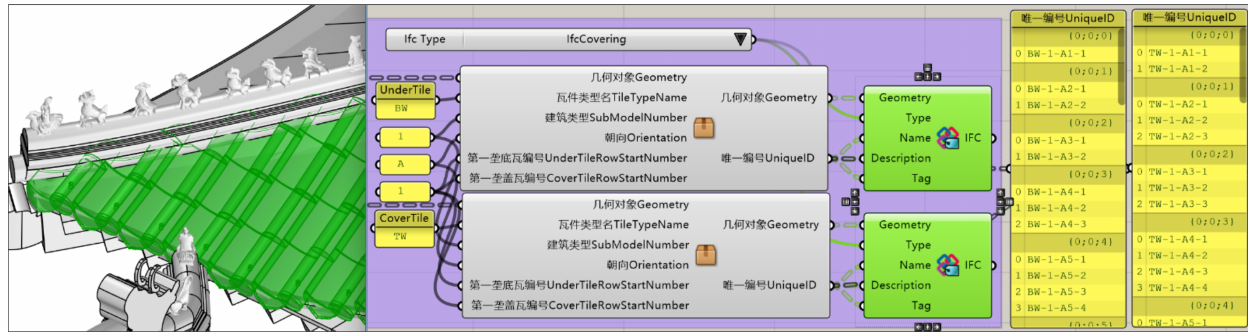
Figure 7. The steps of algorithm modeling for roof tiles at the corner with the gutter.